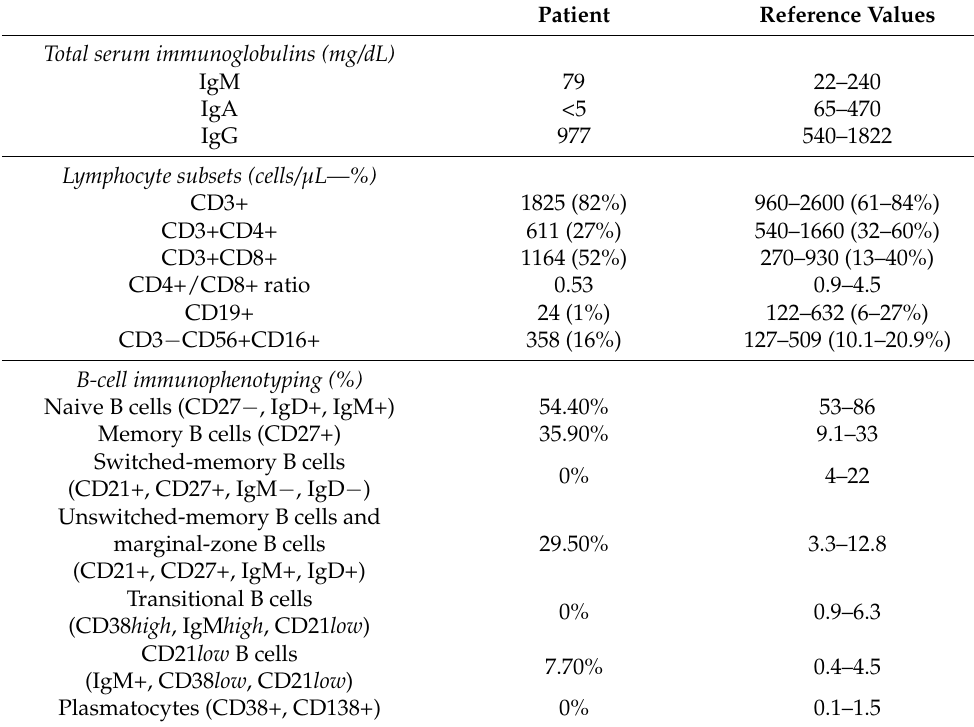
Table 1. Immunological features of the CVID patient in current treatment with intravenous im- munoglobulins previous to the SARS-CoV-2 vaccination. Ig: immunoglobulin.